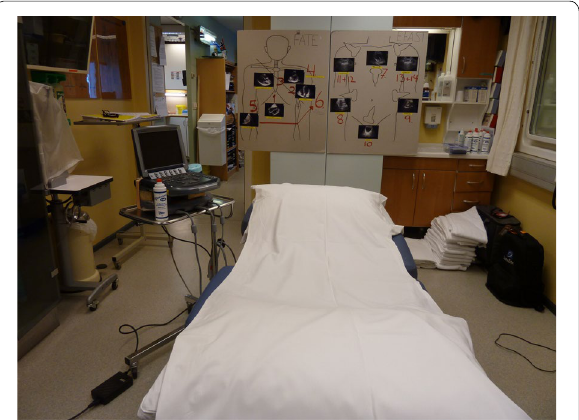
Fig. 3 Scanning positions. Offshore hospital bed with M-Turbo ultrasound machine and wall-mounted scanning cards for Focused Assessed Transthoracic Echo (FATE) and extended Focused Assessment with Sonography for Trauma (e-FAST). Ultrasound video clips and images were recorded from all 14 positions. Photo: Nils Petter